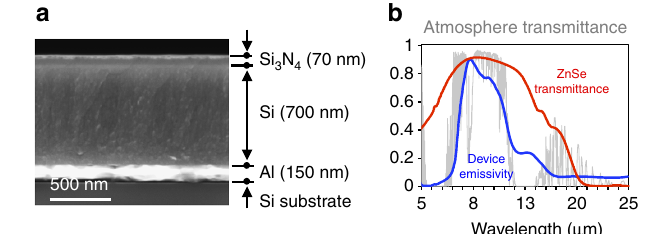
Figure 3 | Structure and spectrum of the selective emitter. ( a ) Cross- sectional scanning electron microscope image. ( b ) Spectral emissivity of the selective emitter (blue), measured using Fourier transform infrared spectroscopy and averaged over both polarizations, aligns very well with the atmospheric transmittance (grey). The ZnSe window (red) also confirmed to be transparent throughout the atmospheric transparency window. For clarity, here only show results along normal